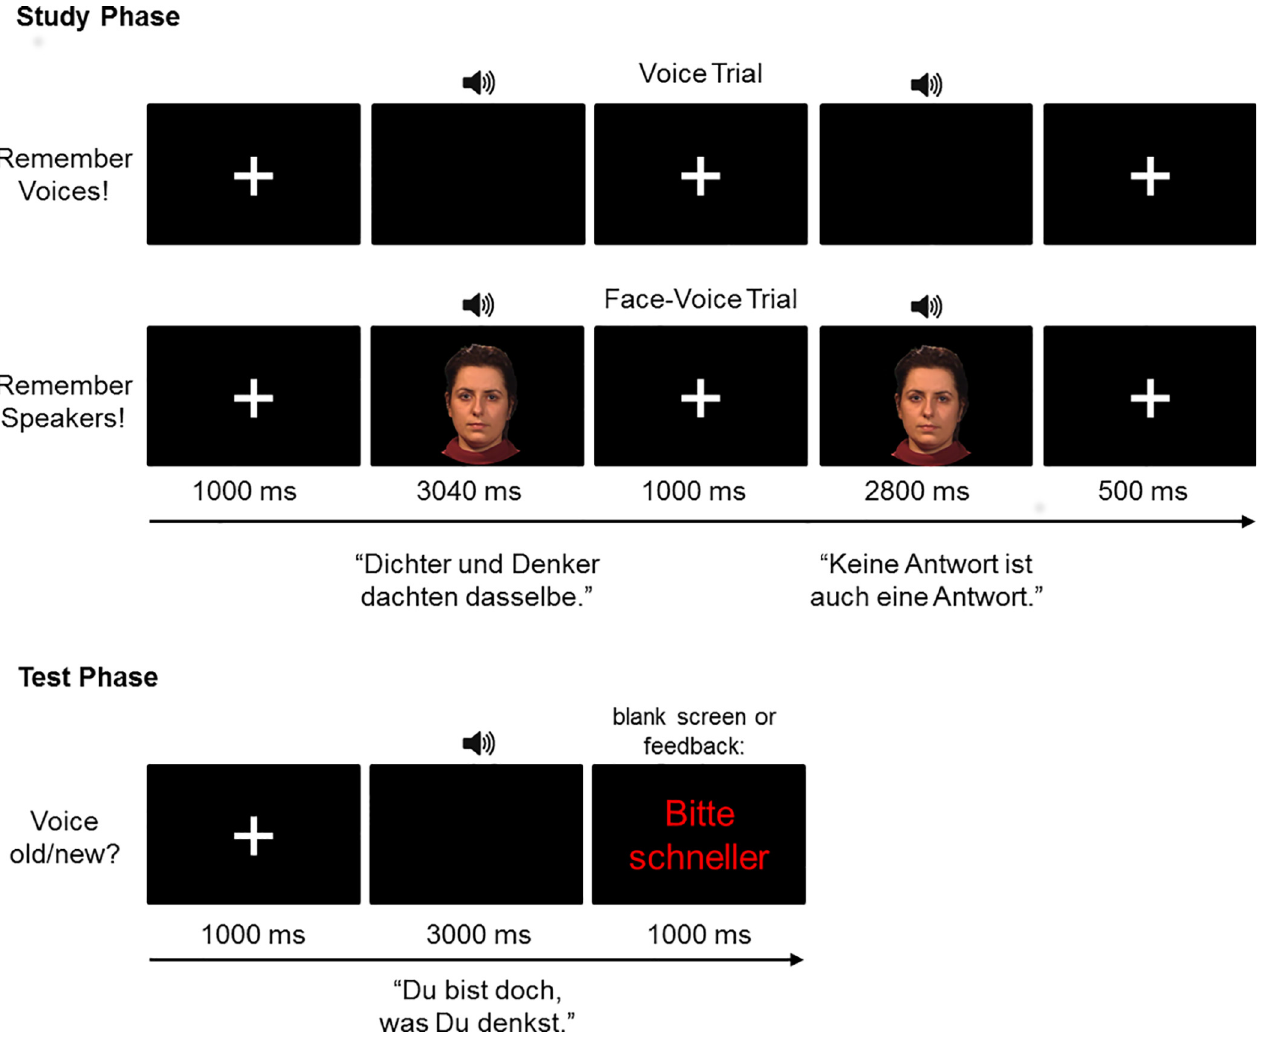
Fig 1. Top: Trial procedure for the study phases depicted for the voice-only block (V) and the face-voice block (FV). Bottom: Trial procedure in the test phases following V and FV learning. Note that face stimuli were static pictures in Exp. 1 and dynamic videos in Exp. 2. The individual depicted in this figure has given written informed consent (as outlined in PLOS consent form) to publish this